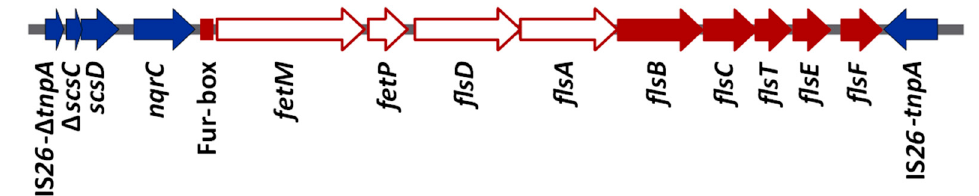
Figure 1. Schematic representation of the fetMP - fls region of plasmid pUO-StVR2 (flanked by truncated and intact copies of insertion sequence IS 26 ). Genes fetMP - flsDA deleted in the mutant used to investigate the function of the putative FetMP-Fls iron acquisition system are indicated by white arrows; red arrows designate other fls genes, the small red square—a putative Fur box, and the blue arrows—additional genes in the fetMP - fls region. The ORFs from fetM to flsF were previously designated as ORF-R1 to ORF-R9 [24].